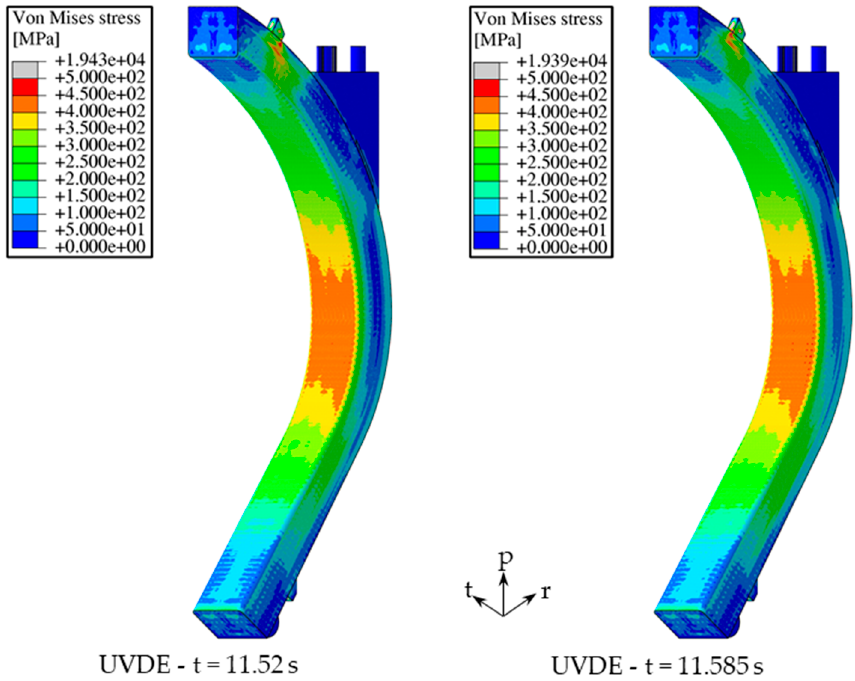
Figure 12. Von Mises stress field under UVDE (t = 11.52 s and t = 11.585 s) loading scenarios.